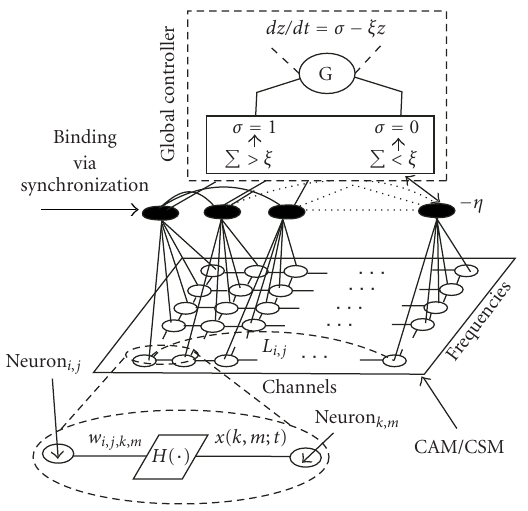
Figure 4: Architecture of the two-layer bio-inspired neural net- work. G stands for global controller (the global controller for the first layer is not shown on the figure). One long-range connection is shown. Parameters of the controller and of the input layer are also illustrated in the zoomed